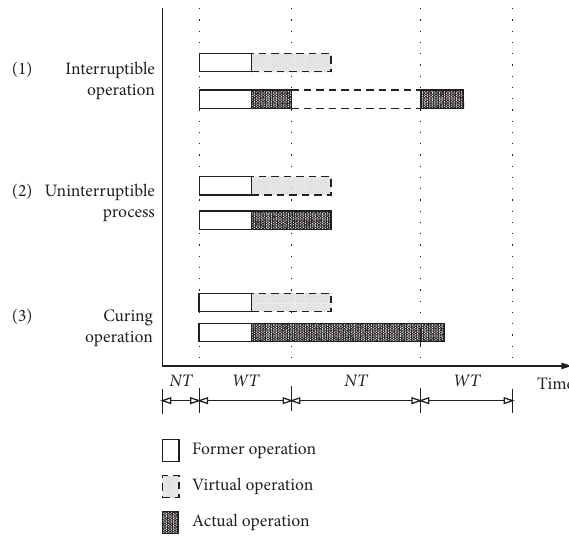
Figure 4: Process arrangement Table 1: Operation time and weight value of the six components in each process.